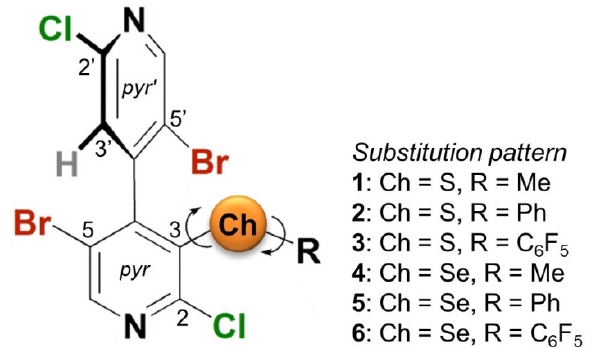
Figure 1. Structure of ( M )-5,5′-dibromo-2,2′-dichloro-3-chalcogeno-4,4′-bipyridines 1 – 6 .